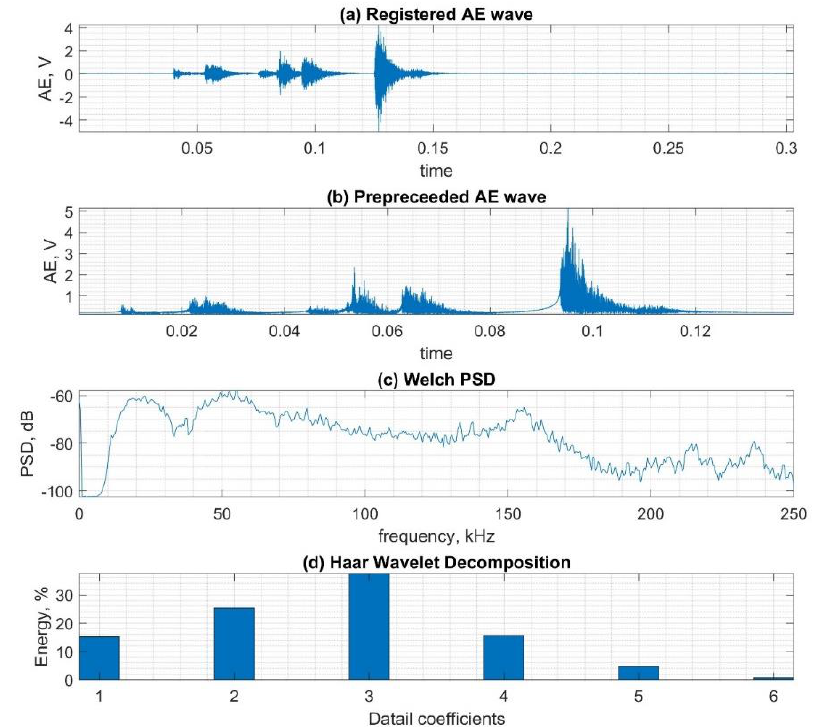
Figure 2. Process of preparing data for classification, considering sample signal for class C1 sensor type R15. ( a ) Registered waveform, ( b ) pre-processed signal, ( c ) power spectrum density calculated using the Welch method, ( d ) Energy of wavelet decomposition coefficients calculated using Haar wavelet.